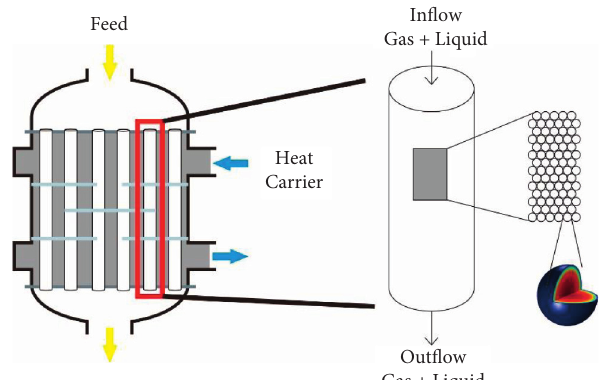
Figure 1: Trickle-bed reactor modelling